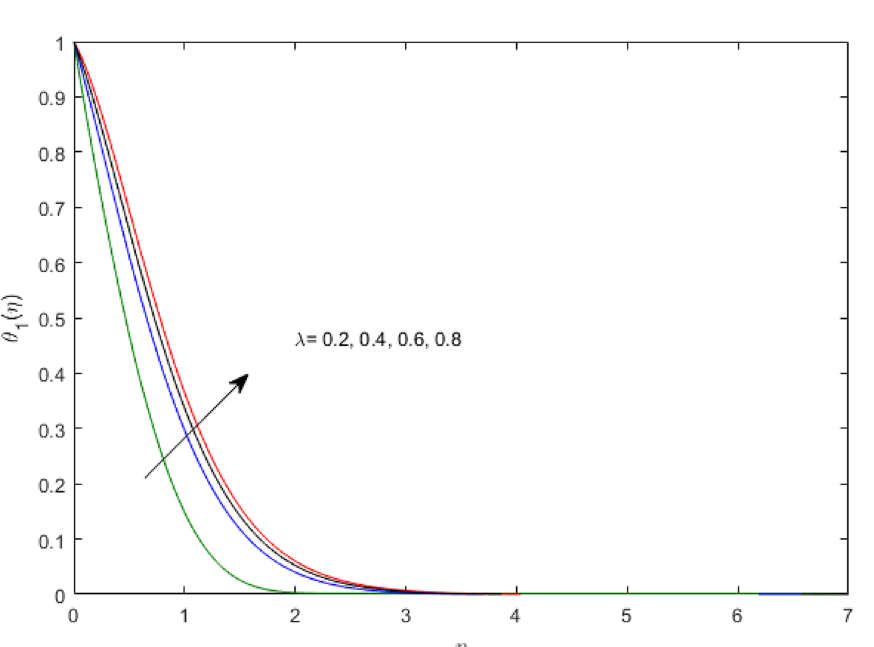
Figure 6. θ 1 (η) versus varied estimates of (cid:31)